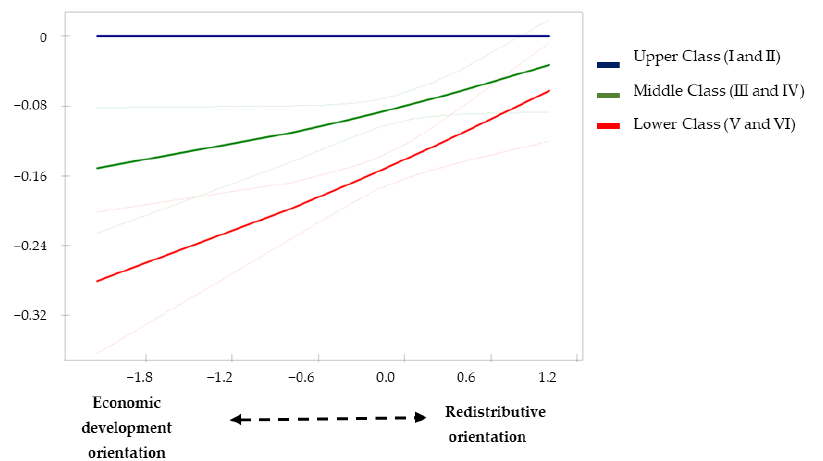
Figure 1. Differences in health status compared with Upper Class (I and II) according to local spending orientation (Model 3, Table 2).